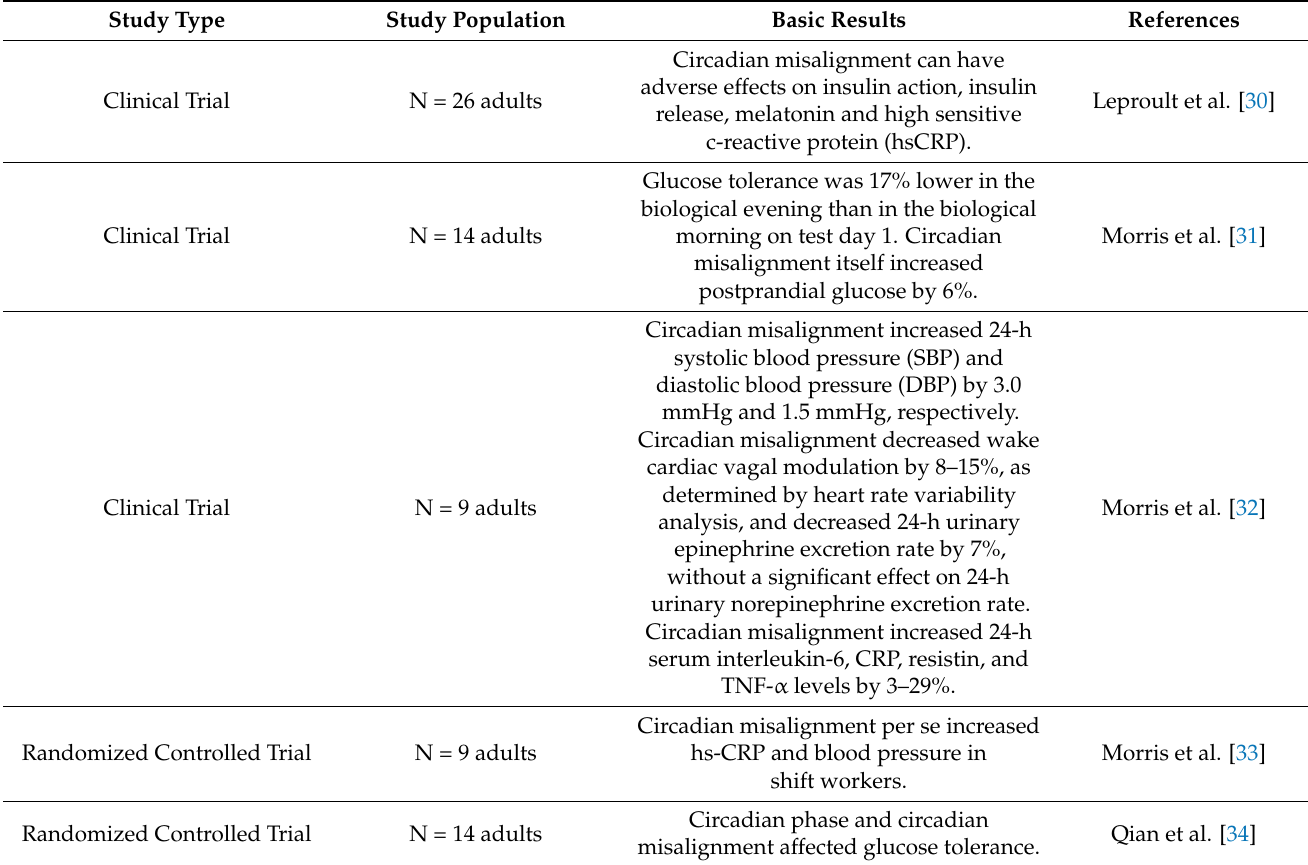
Table 1. Clinical studies analyzing the relationship between circadian rhythms and metabolic